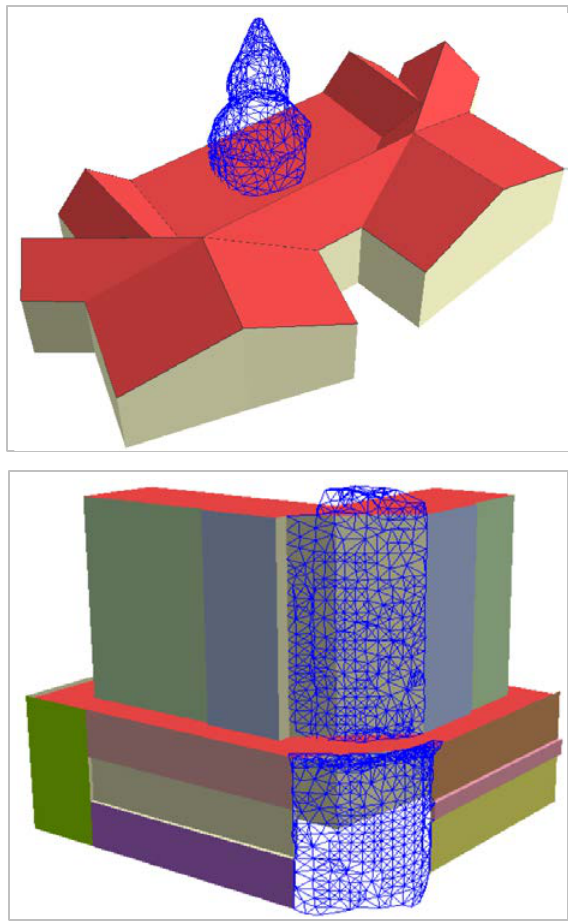
Figure.3. Final output hybrid models . Hybrid models for S1 and S2 data are illustrated in top and bottom,